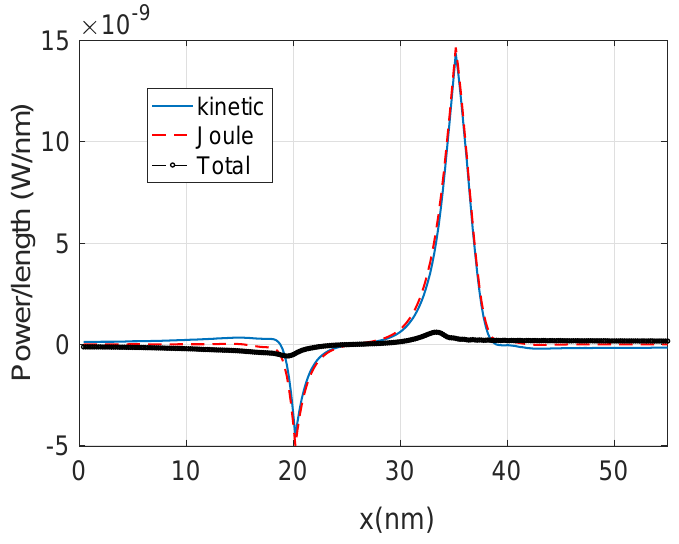
Figure 6. Local power dissipated along the device axis. Vg = 0.4 eV. The thin line and the dashed line represent the corresponding values of the kinetic term and the Joule term in Equation (48) of the text. The thick line represent the total power (the subtraction of the two graph). It should noted that the actual power dissipated inside the device (signed area under the curve) is much smaller than the Joule power (Joule term).